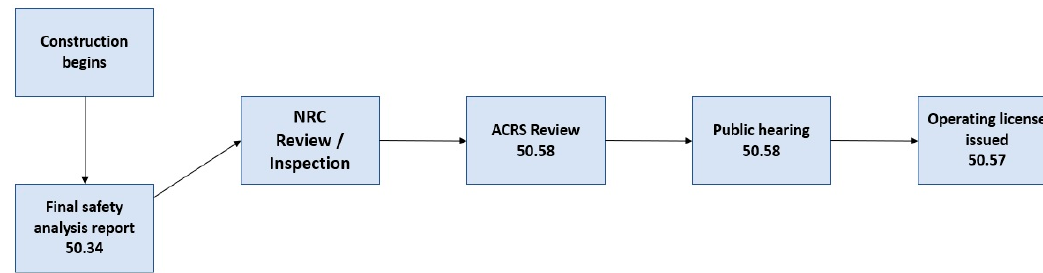
Figure 4. OL process of 10 CFR Part 50.